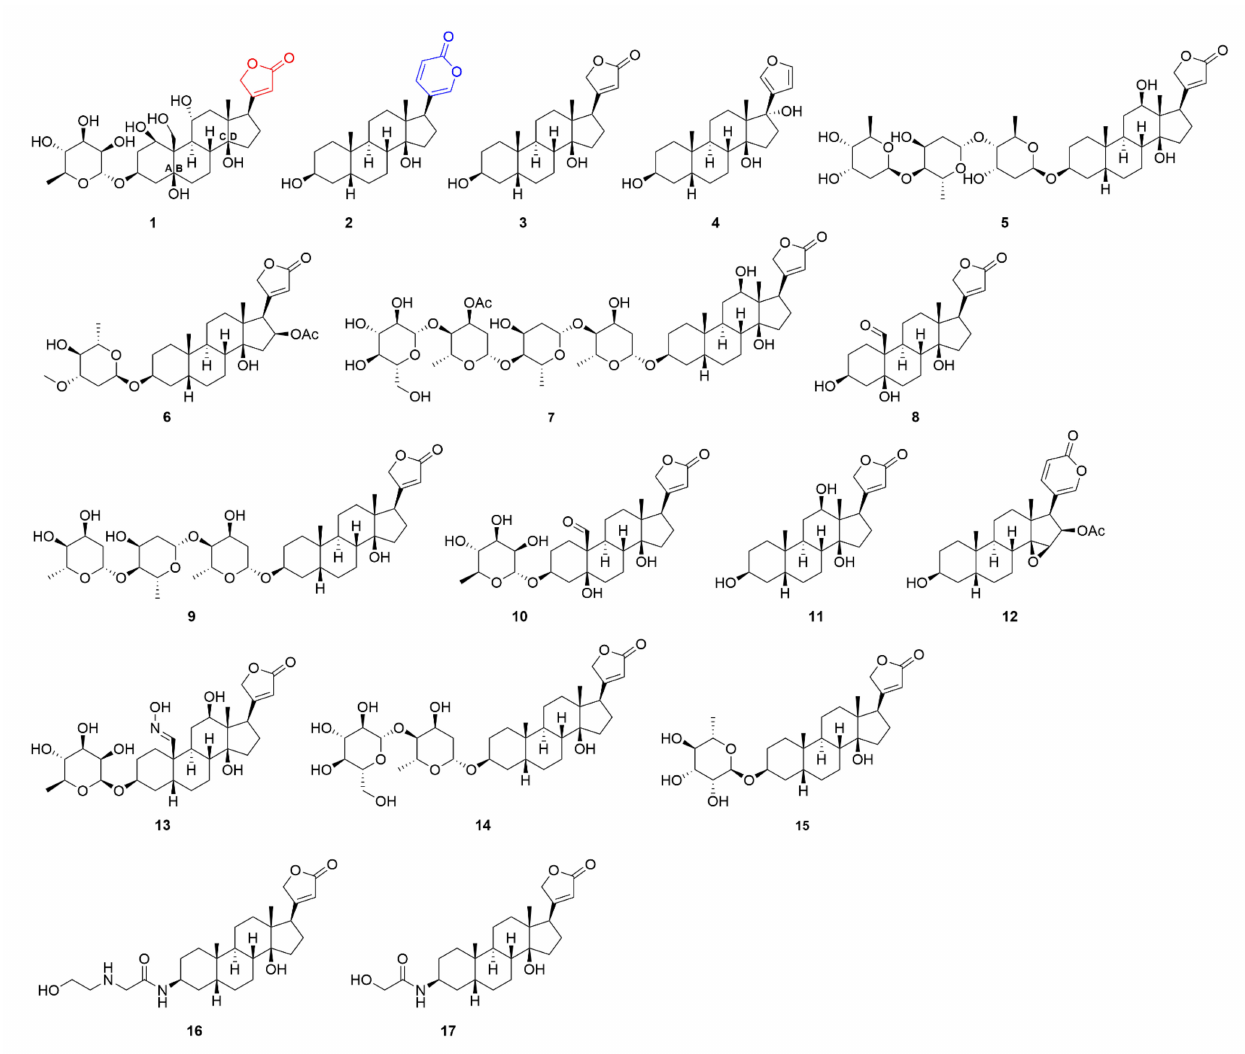
Figure 1. Chemical structures of cardenolide ouabain ( 1 ), bufadienolide bufalin ( 2 ), digitoxigenin ( 3 ) and its derivative rostafuroxin ( 4 ), digoxin ( 5 ), oleandrin ( 6 ), lanatoside C ( 7 ), strophanthidin ( 8 ), digitoxin ( 9 ), convallatoxin ( 10 ), digoxigenin ( 11 ), cinobufagin ( 12 ), a semisynthetic cardenolide RIDK-34 ( 13 ), glucoevatromonoside ( 14 ), evomonoside ( 15 ), C10 ( 16 ), and C11 ( 17 ). Compound 1 has a five-membered lactone ring (in red) and compound 2 has a six-membered lactone ring (in